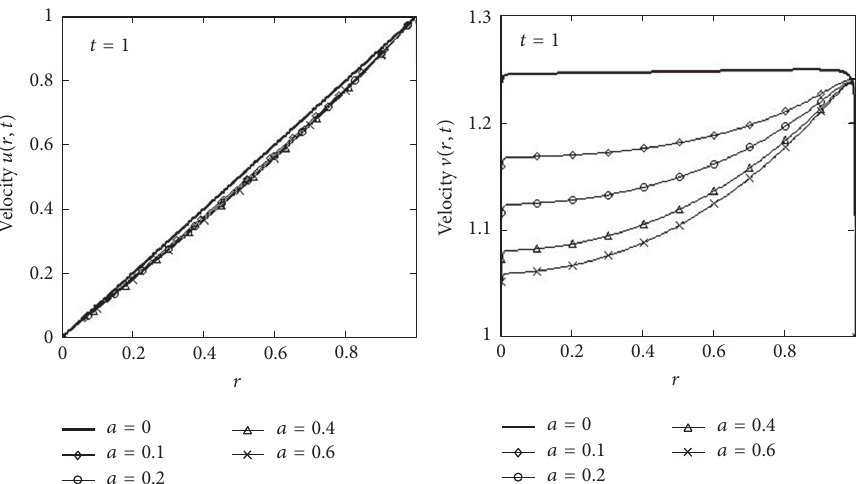
Figure 2: Profiles of azimuthal velocity 𝑢(𝑟, 𝑡) and axial velocity V (𝑟, 𝑡) for 𝑡 = 1 and different values of the scale parameter 𝑎 .